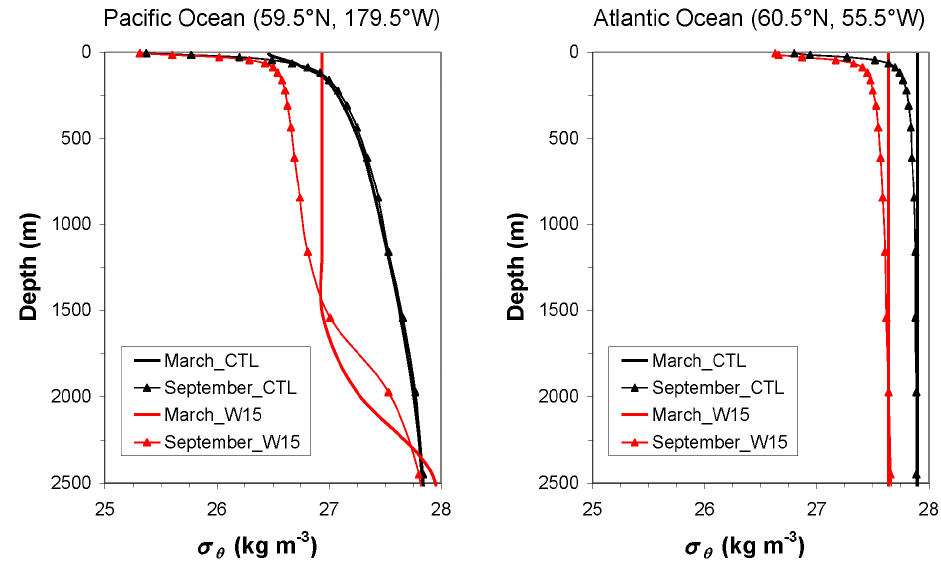
Figure 10. March and September averaged potential density profiles with or without OTEC at selected northern high-latitude locations: Pacific Ocean ( left ) and Atlantic Ocean ( right ).